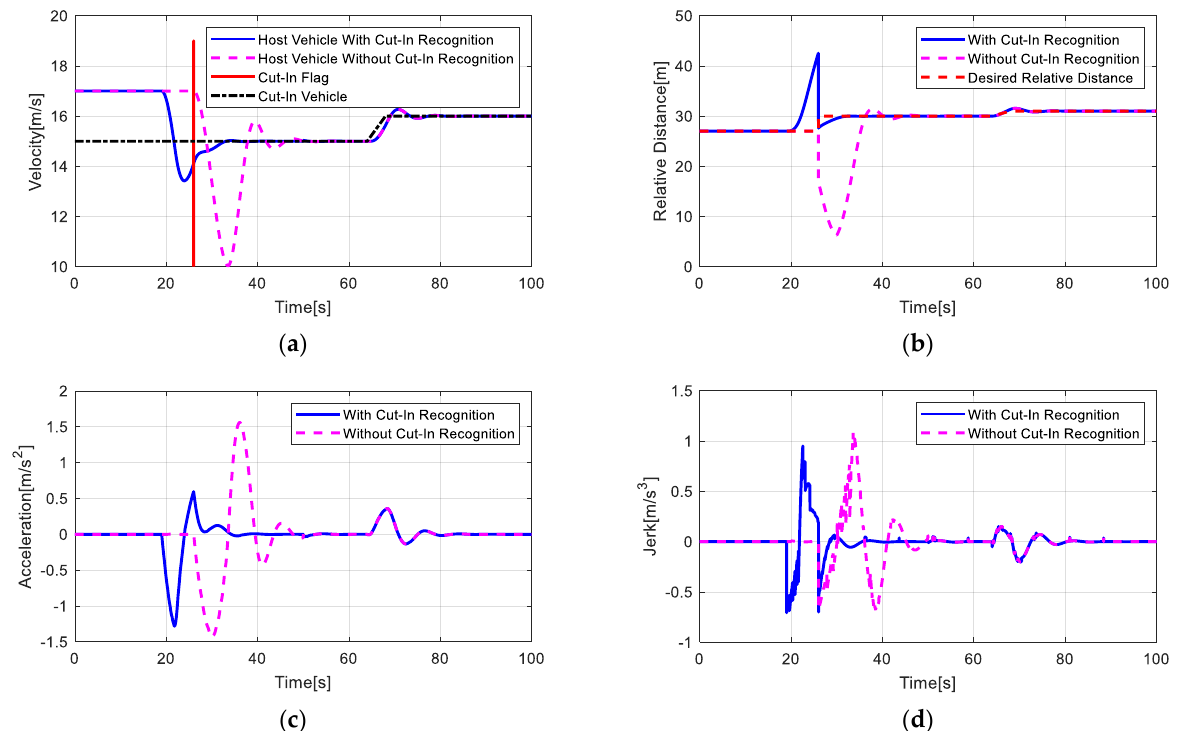
Figure 23. The simulation results of cut-in within a safe distance scenario: ( a ) the velocity comparison of the host vehicle with cut-in recognition and the host vehicle without cut-in recognition; ( b ) the following distance comparison of the host vehicle with cut-in recognition and the host vehicle without cut-in recognition; ( c ) the acceleration comparison; and ( d ) the jerk comparison.